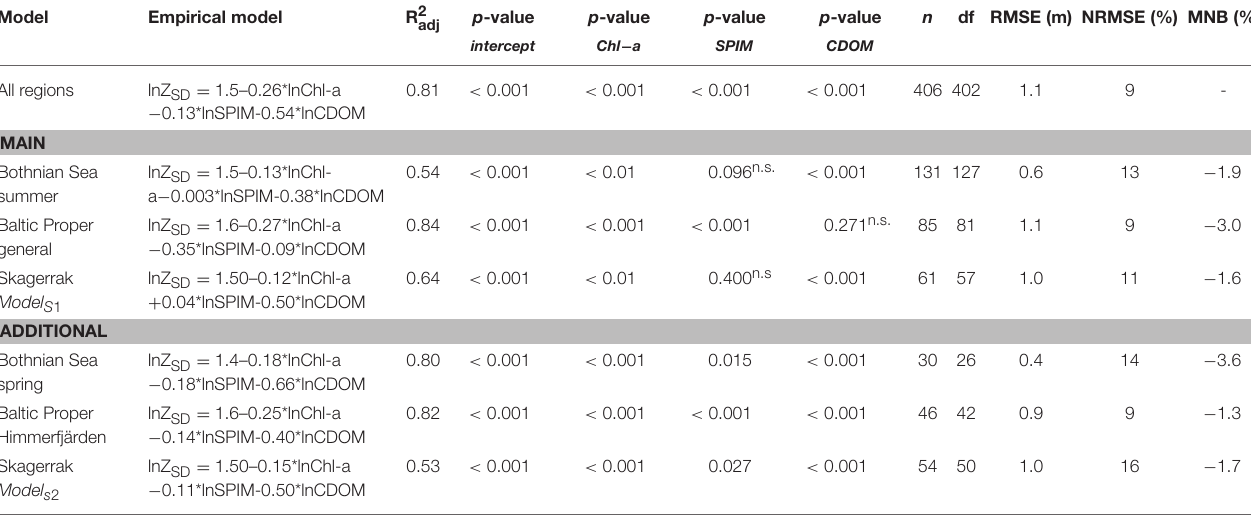
TABLE 3 | Results from the empirical multiple regression models per region, based on the data selection from the GLM’s.